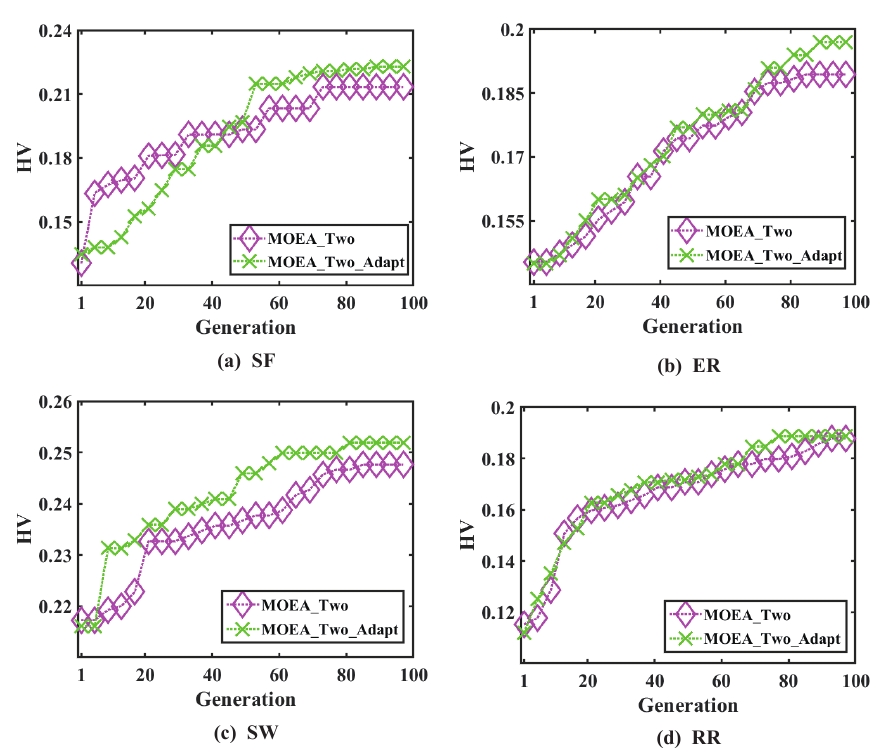
Figure 6. HV values of MOEA_Two and MOEA_Two_Adapt in four types of